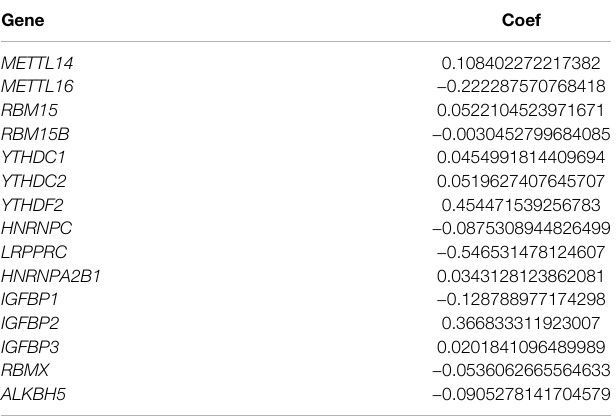
TABLE 5 | The Co-ef fi ciency (Coef) for m6A